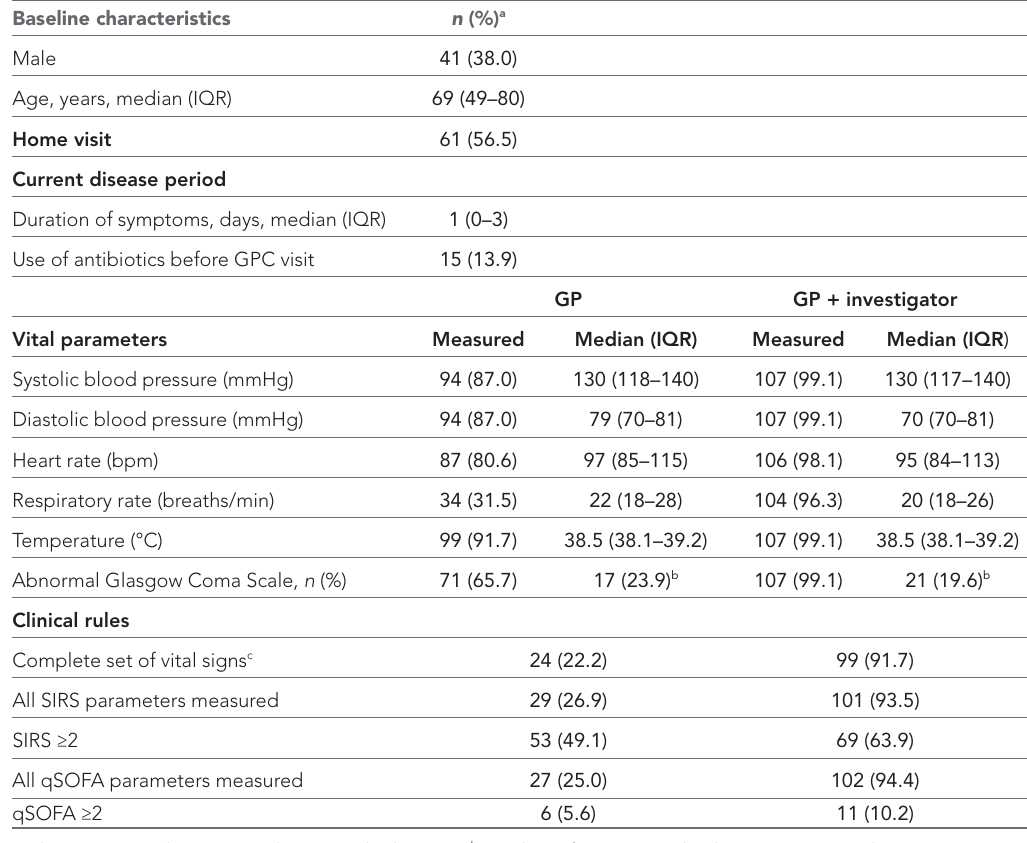
Table 1 Baseline characteristics and measurements of vital signs ( N = 108) Baseline